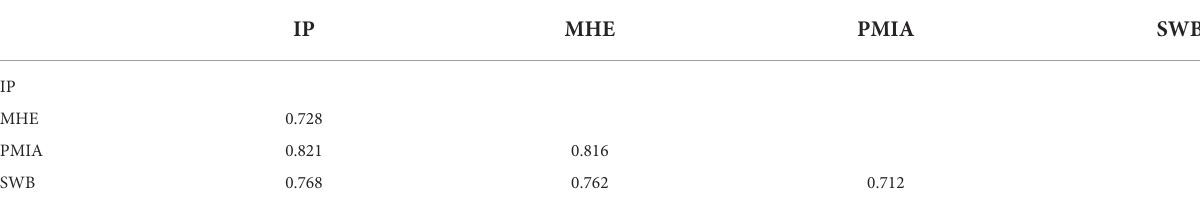
TABLE 2 Discriminant validity.